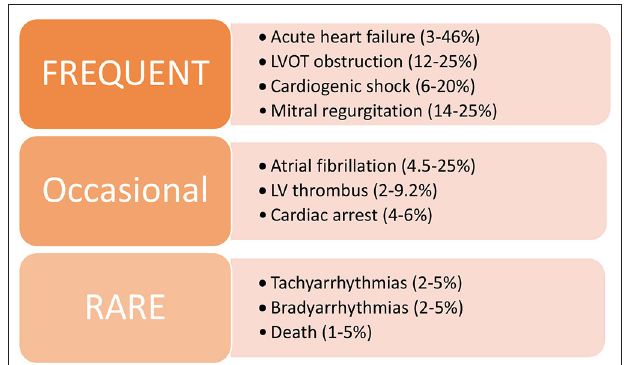
FIGURE 4 | Summary of common in-hospital complications associated with stress